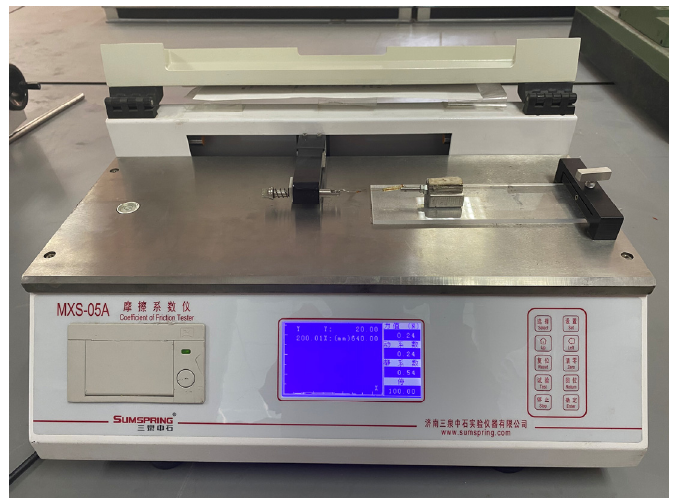
Figure 5. Test of the static friction coefficient of urea particles.